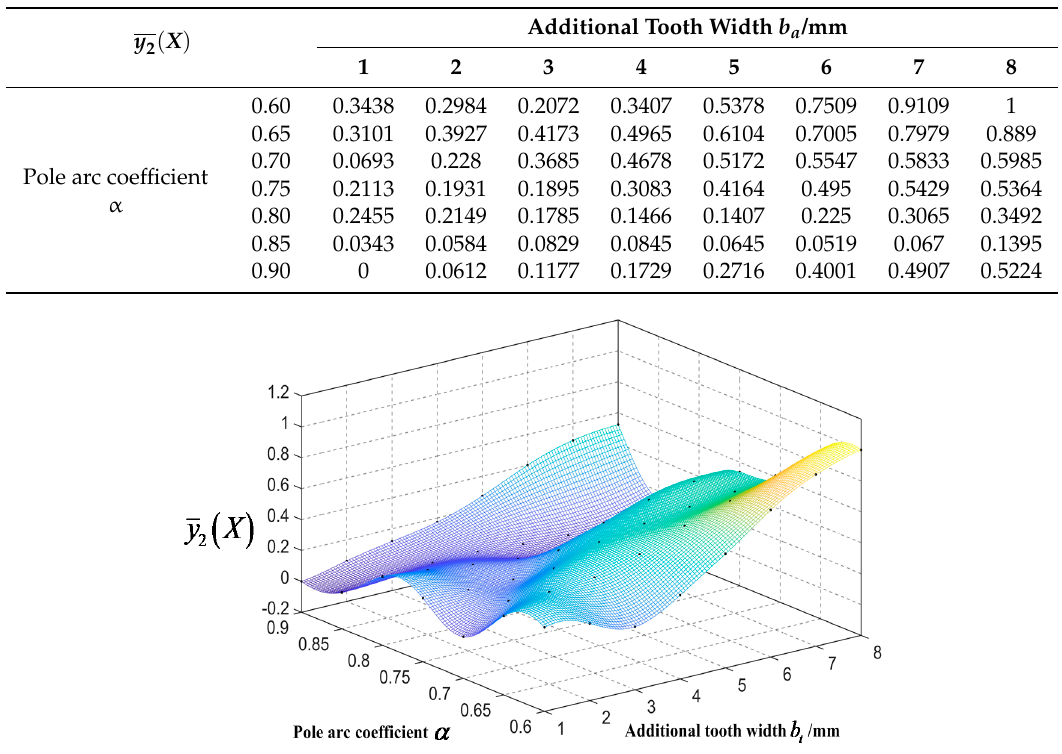
Table 4. Normalized objective value y 2 ( X ) .